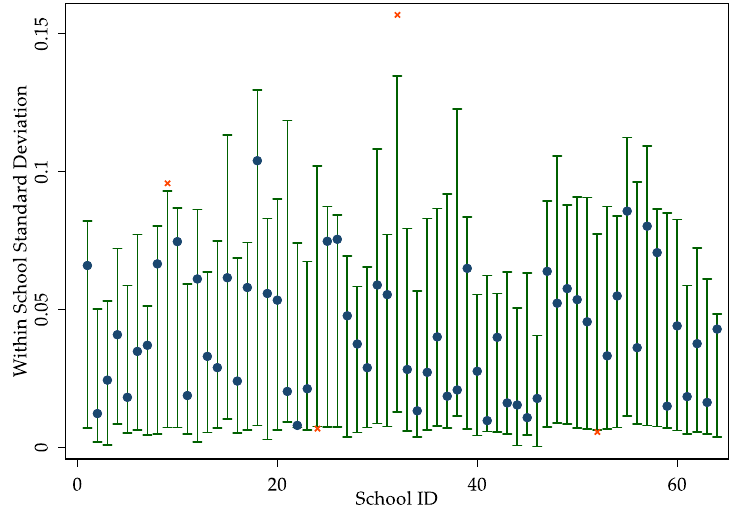
Figure 1. Monte Carlo Simulations of left behind children (LBCs) share. Notes: The figures present the Monte Carlo simulations for the within-school standard deviation in the share of LBCs. Vertical bars represent simulated 95% confidence intervals for within-school standard deviations in the share of LBCs. Scatter points represent actual within-school standard deviations for each school. Filled circles indicate that the actual standard deviation is within the simulated 95% confidence interval, whereas x’s indicate schools with standard deviations outside the simulated confidence interval.